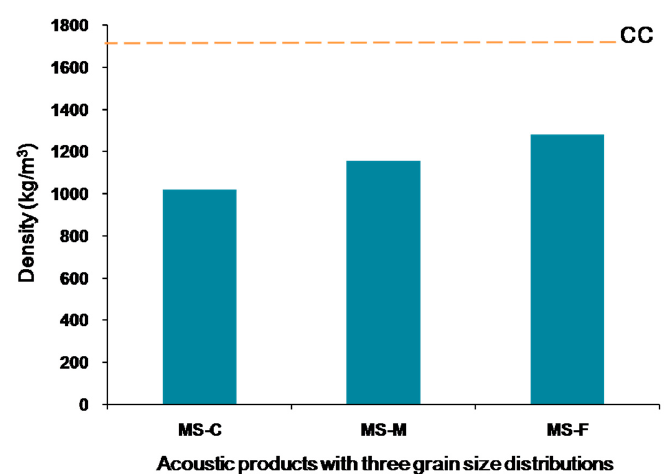
Figure 3. Density of the MS-C, MS-M and MS-F acoustic products compared with coarse porous cement (CC).